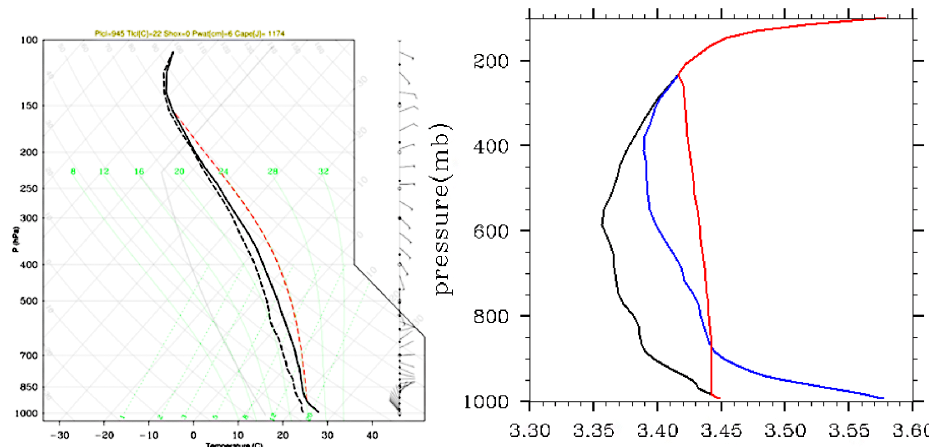
Figure 2. Skewt diagram (left) displaying temperature (solid black line), dew point (dashed black line), vertical wind profile and the CAPE (Convective Available Potential Energy) parcel profile (dashed red). Also shown are vertical profiles (right) of moist static energy (black), saturation moist static energy (blue) and simulated updraft moist static energy (red). Units for the